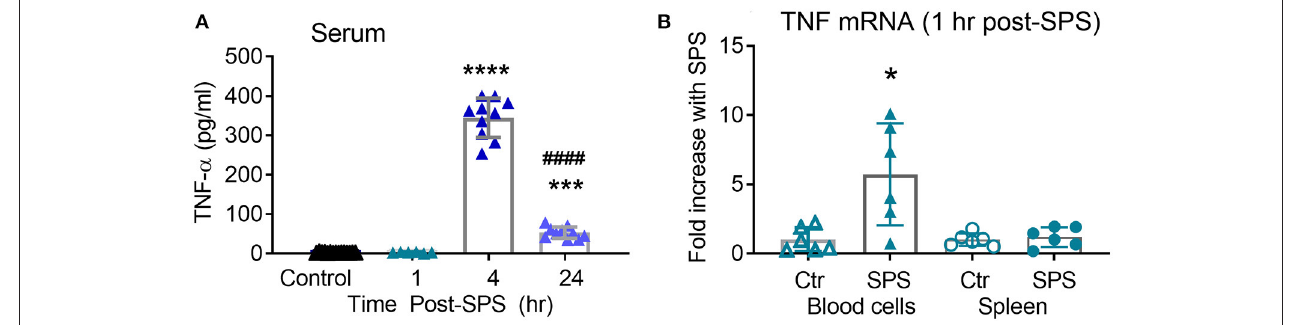
FIGURE 7 | Serum TNF- α increases 4–24h post-SPS. Serum samples collected for blood brain barrier permeability also were assayed for TNF- α levels by ELISA (A) , data presented as scatter plot with mean ± 95% CI ( N = 6–16/group). TNF- α mRNA (B) increased in circulating blood cells ( p < 0.05), but not spleen, 1h post-SPS